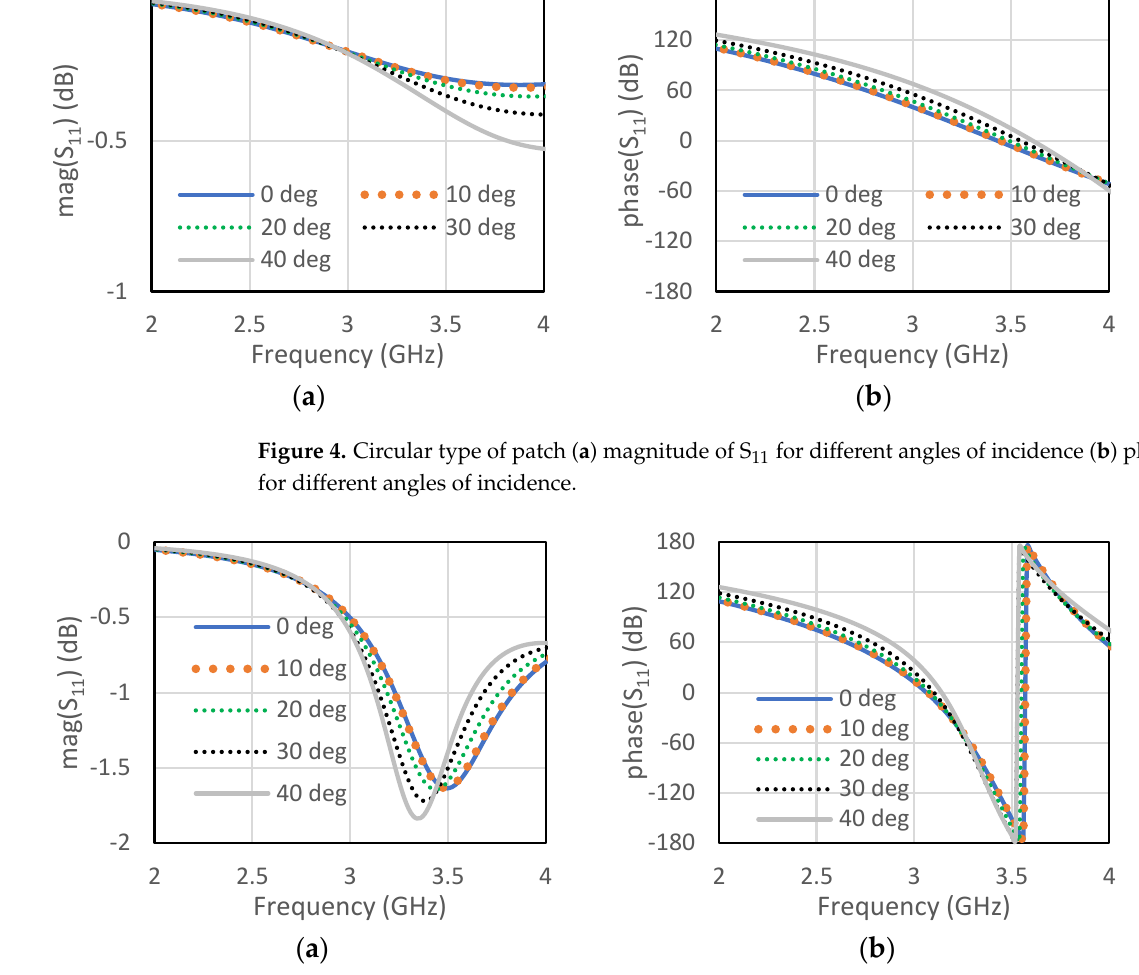
Figure 5. Circular patch with a ring ( a ) magnitude of S 11 for different angles of incidence ( b ) phase of S 11 for different angles of incidence.